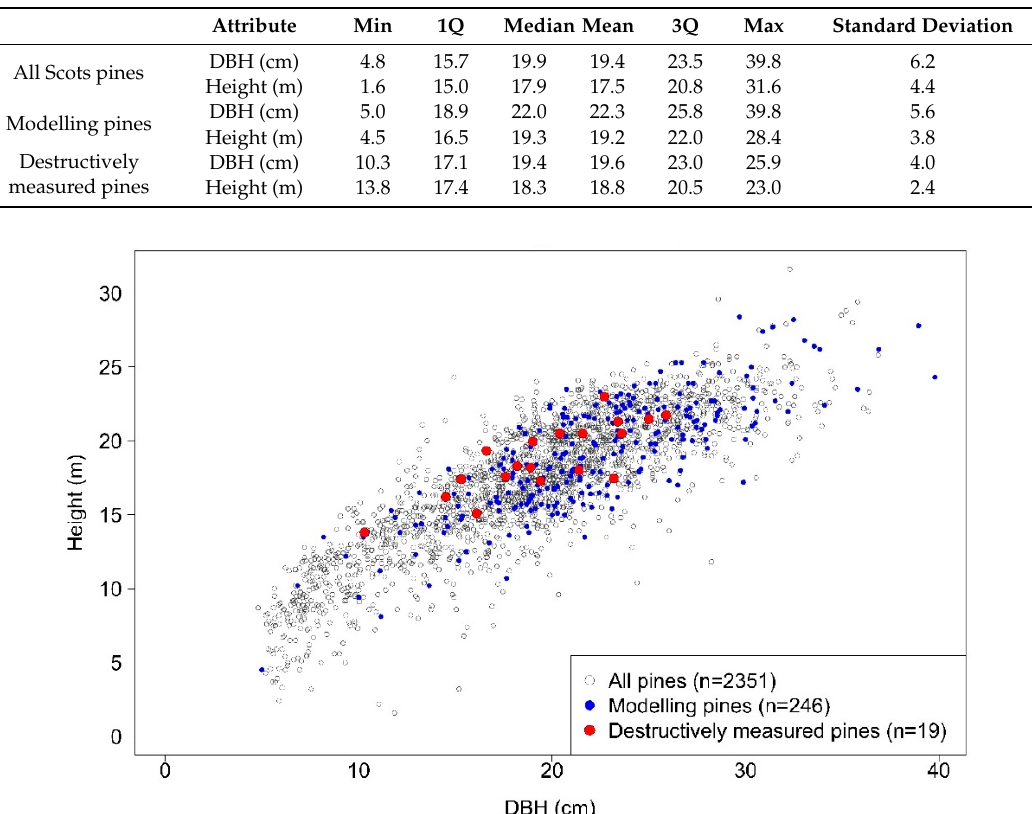
Figure 4. Relationship between diameter-at-breast height (DBH) and height of all Scots pines in 37 sample plots within the study area, Scots pines with taper curve measurements from terrestrial laser scanning and used for parametrizing the taper curve (i.e., modelling pines), and Scots pines measured destructively.